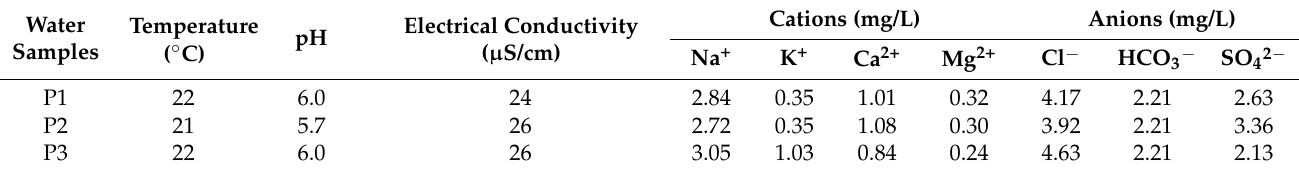
Table 3. Physicochemical data of waters from the area of the Regoufe Table 4. Potentially toxic elements and Fe in waters from the area of the Regoufe mine.